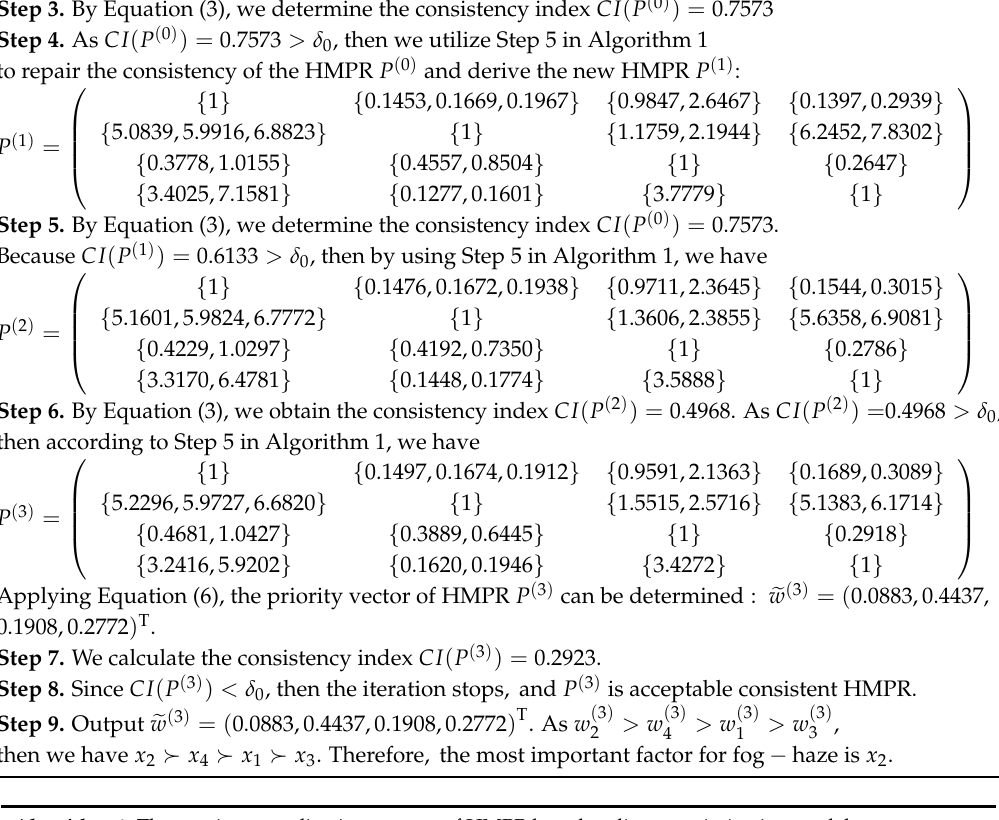
Algorithm 4: The consistency adjusting process of HMPR based on linear optimization